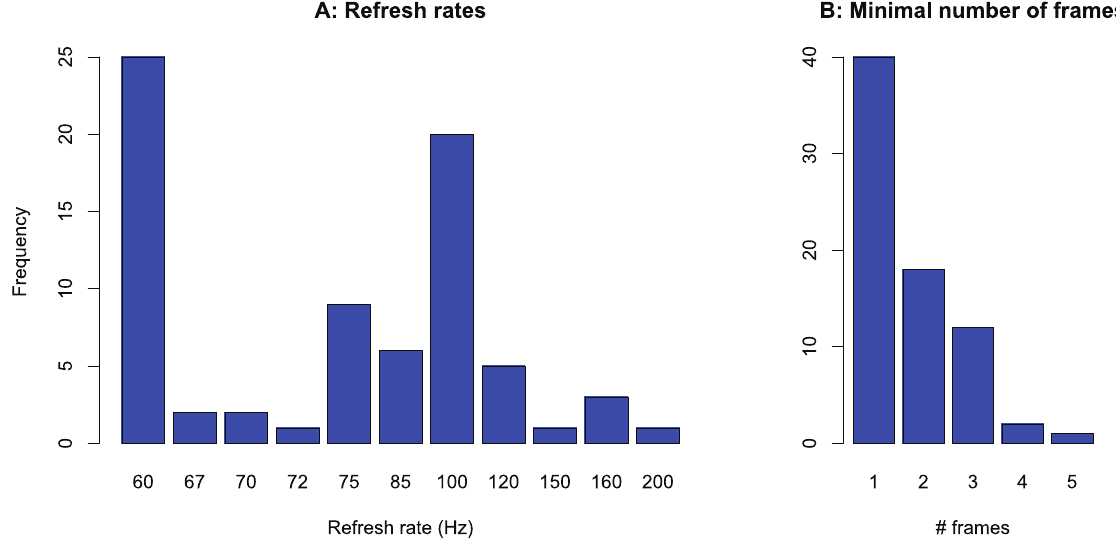
Figure 5. Display timing characteristics in the literature review studies. Frequency of refresh rates (A) and the minimal numbers of frames (B) used in the experiments.